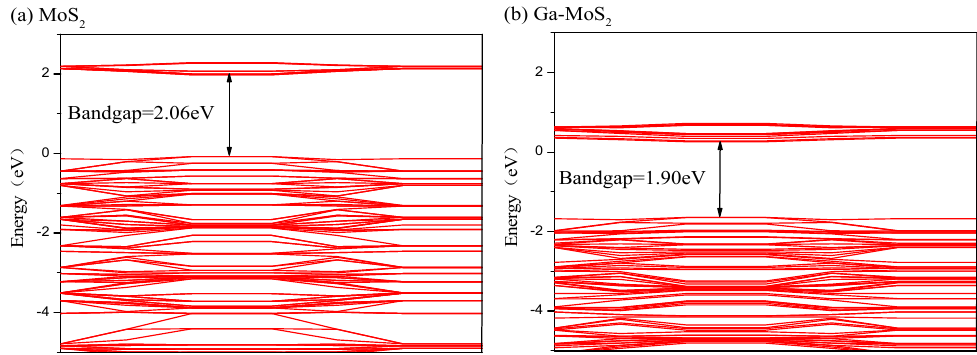
Figure 3. The energy band of ( a ) MoS 2 ( b ) Ga-MoS 2 system.